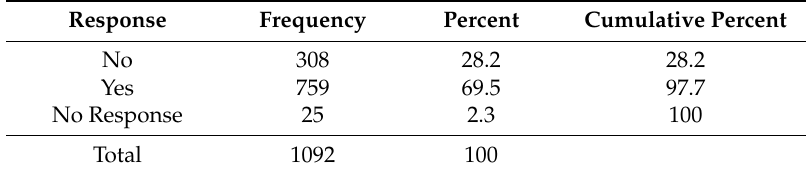
Table 1. Participation in construction projects using e-Procurement